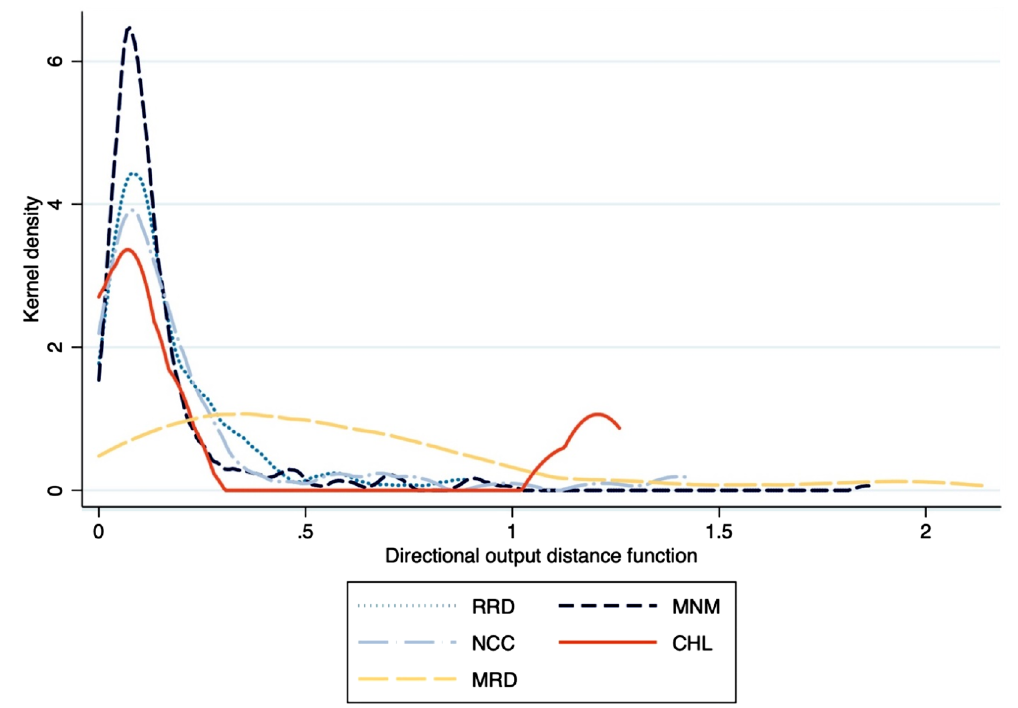
Figure 3. Kernel probability densities of directional output distance, by